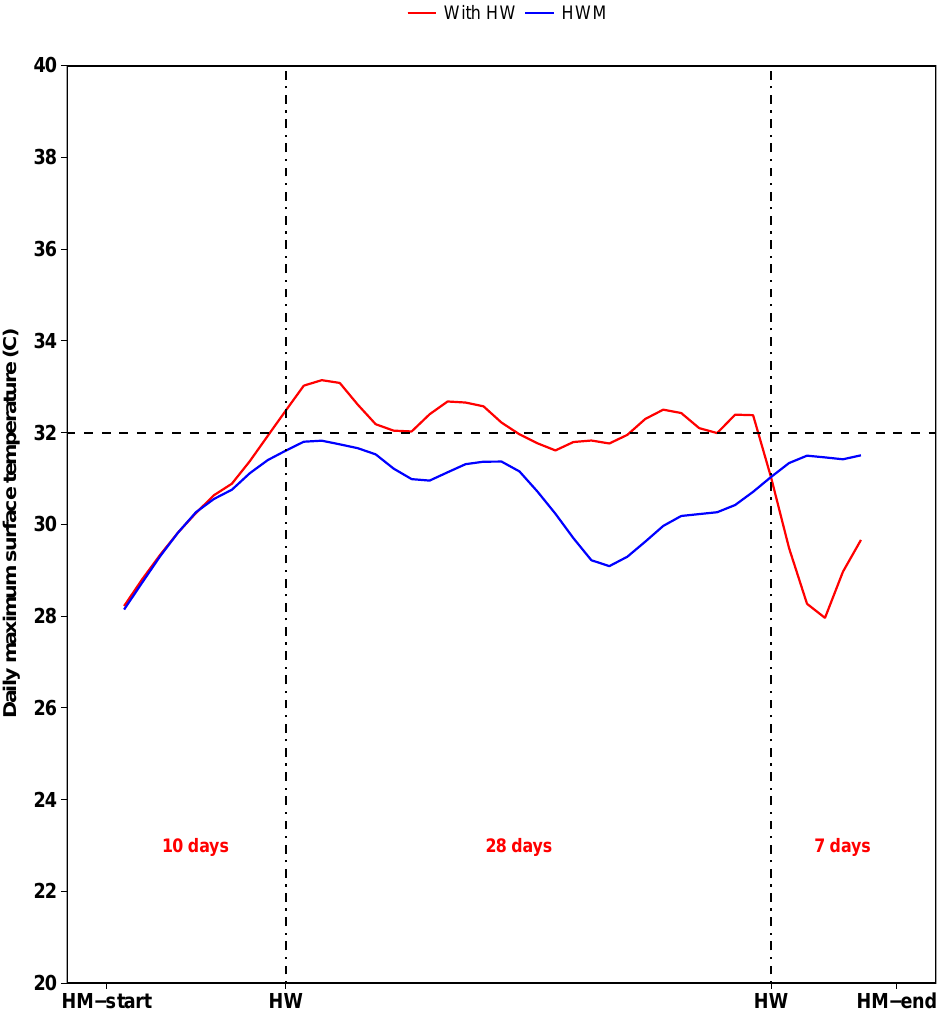
Figure 7. Time evolution of the RRM area-averaged daily maximum surface air temperature ( ◦ C) for a HW condition (red line, dark blue simulation with HWs in Figure A2) and the corresponding ensemble mean HW mitigation (blue line), with a heat wave duration in the control of 28 days (refer to Figure A2 for a detailed description of intermittent RRM experiment). The horizontal dotted line at 32 ◦ C represents the threshold of HWs (refer to Figure A6 for the time evolution of the SAT in all individual identified and suppressed